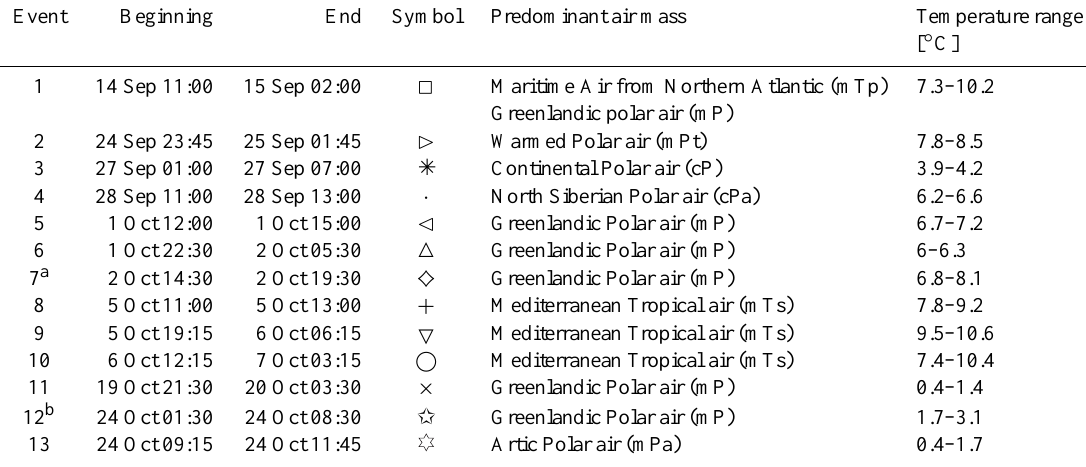
Table 1. Sampling periods for the 13 cloud events probed during the field campaign HCCT-2010. Additionally, symbols used for the graphs within this study, predominant air mass (according to Scherhag (1948) as classified by Tilgner et al. (2012)), and temperature range during the cloud events are